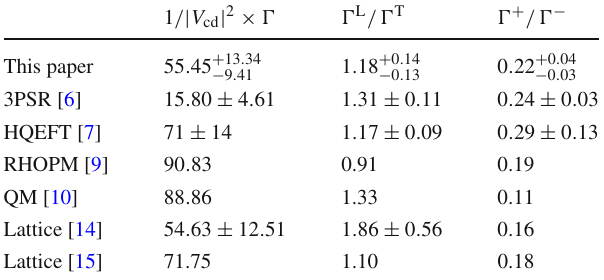
Table 6 Total decay width 1 / | V cd | 2 × (cid:5) , the ratio of longitudinal and transverse decay width (cid:5) L /(cid:5) T , and the ratio of positive and negative decay width (cid:5) + /(cid:5) −